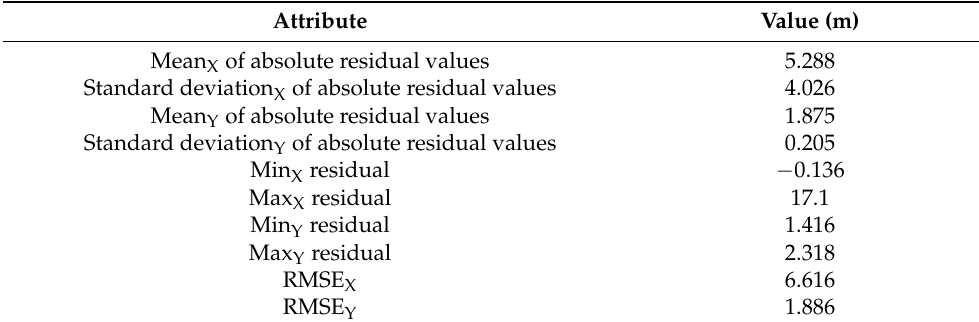
Table 2. Residuals and their relative displacement (mean, standard deviation and Root Mean Square Error (RMSE)).